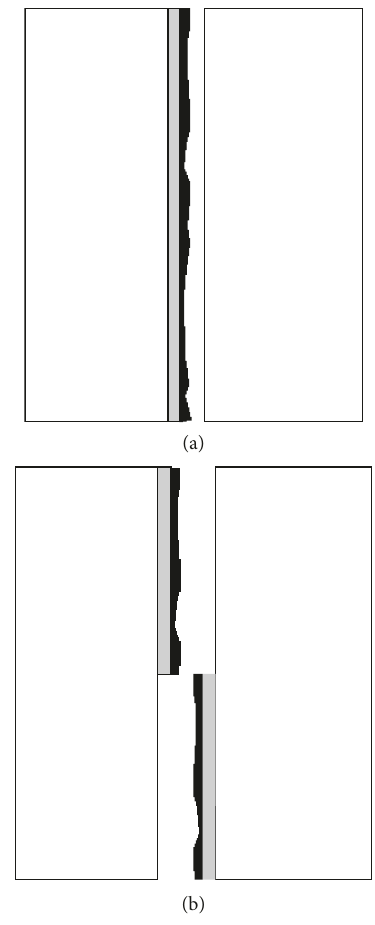
Figure 14: Shear failure in the element/mortar interface: (a) on one surface; (b) divided between two surfaces of the element.